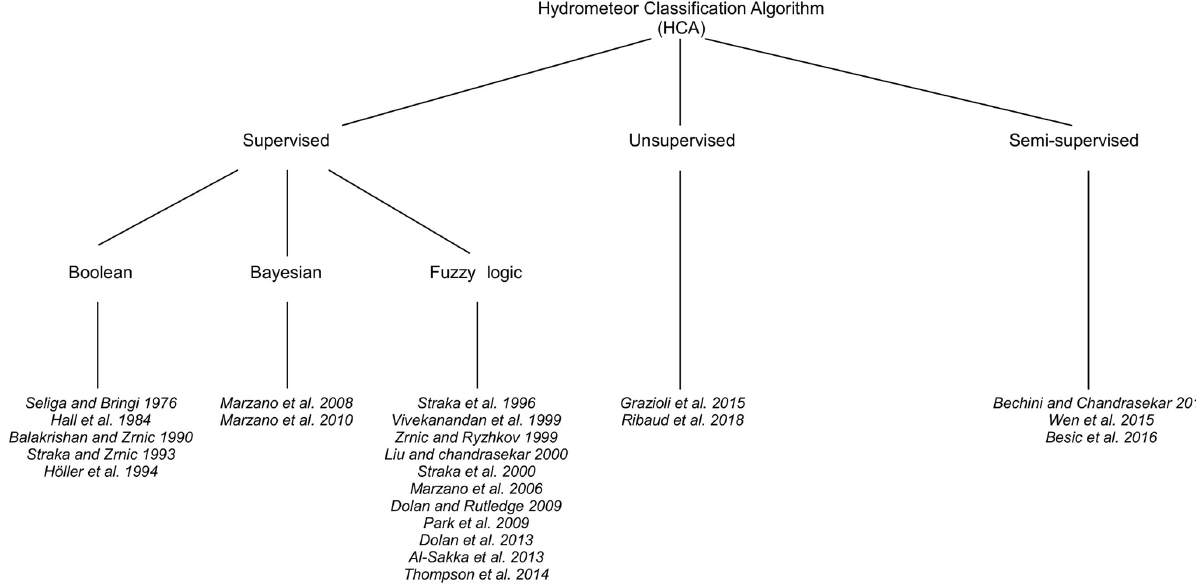
Figure 1. Schematic representation of the different hydrometeor classification techniques and their principal associated